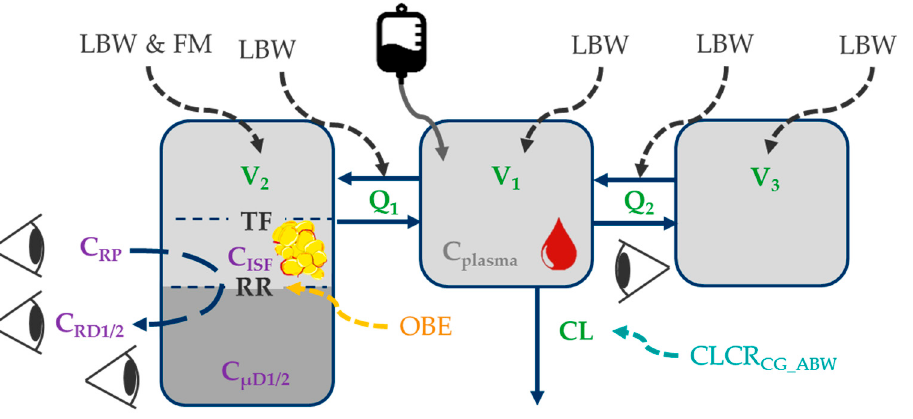
Figure 1. Illustration of the final piperacillin population pharmacokinetic model. Impact of patient characteristics